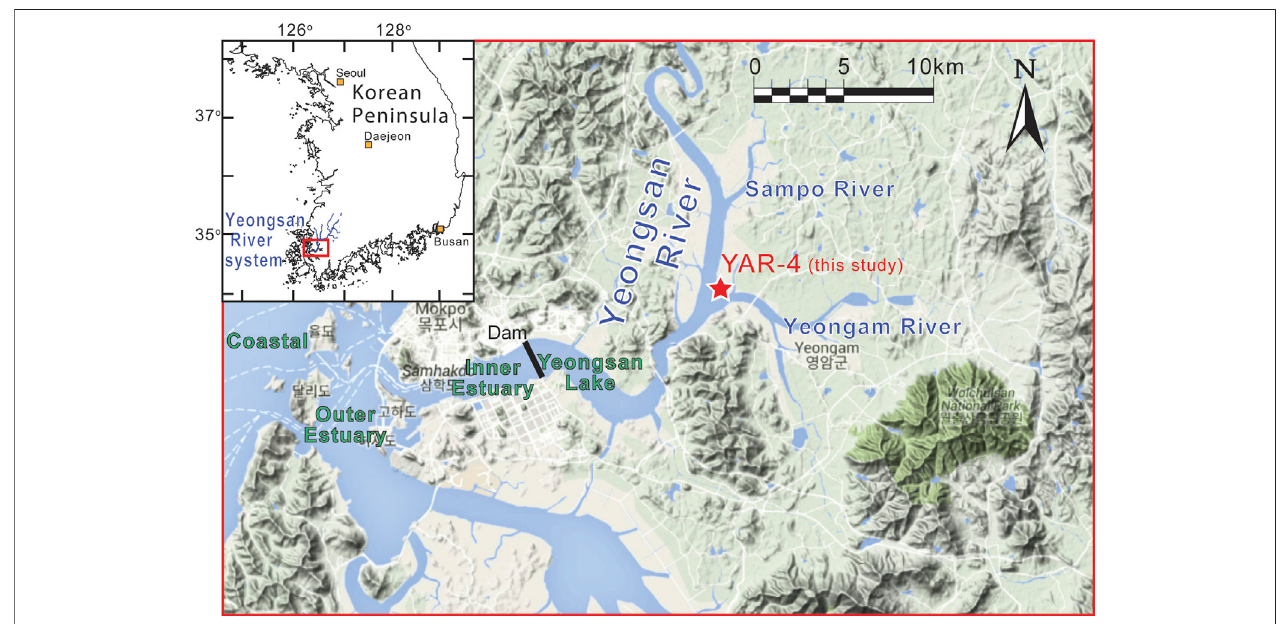
FIGURE 1 | Topographic map of the Yeongsan Estuary showing the location of the YAR-4 core site (red star). Inset: location of the Yeongsan River system (blue lines). Maps were obtained from Google Maps. The location of the Yeongsan Estuarine dam is also shown by black bar.